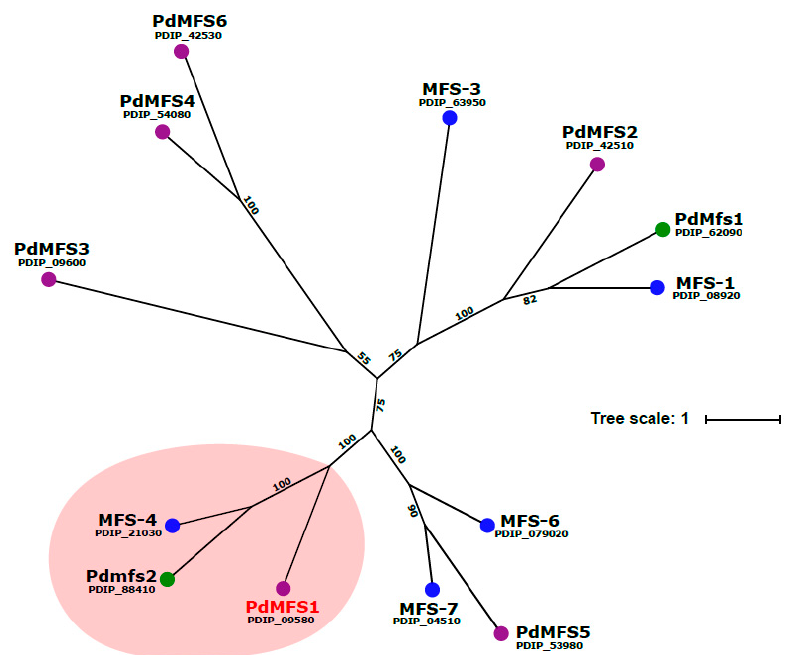
Figure 1. Unrooted Maximum Likelihood phylogenetic tree of selected P. digitatum major facilitator superfamily (MFS) transporters. PdMFS1, the new MFS transporter described in this study, is highlighted in red. Values indicate the number of times (in percent) that each branch topology was found during bootstrap analysis. The National Center for Biotechnology Information (NCBI) accession number is indicated below the name of each transporter.